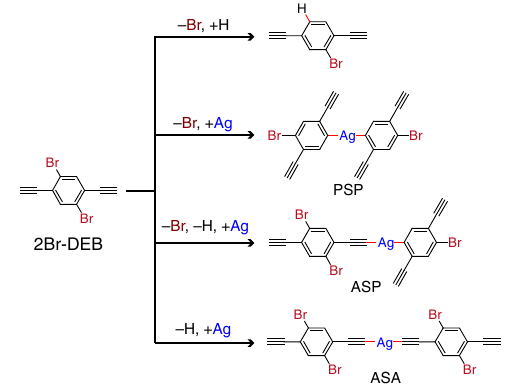
dashed arrows). High-resolution STM image (Fig. 3b) identi fi es